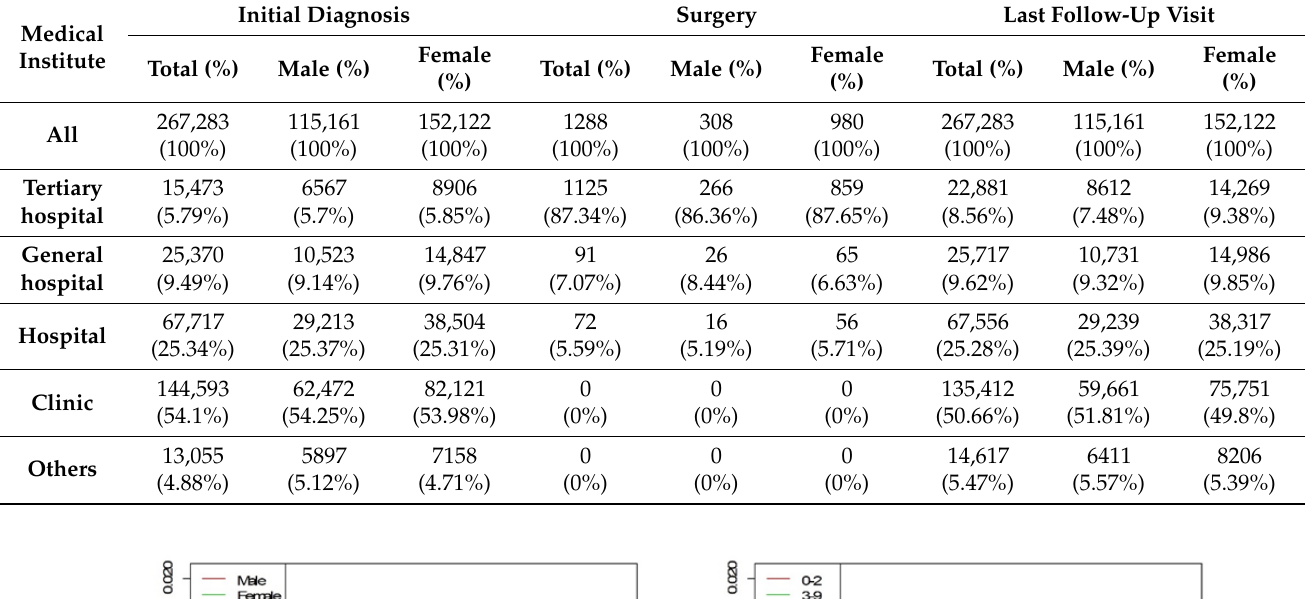
Table 4. Types of medical institutions where idiopathic scoliosis patients were first diagnosed, underwent surgery, and attended last follow-up visits.